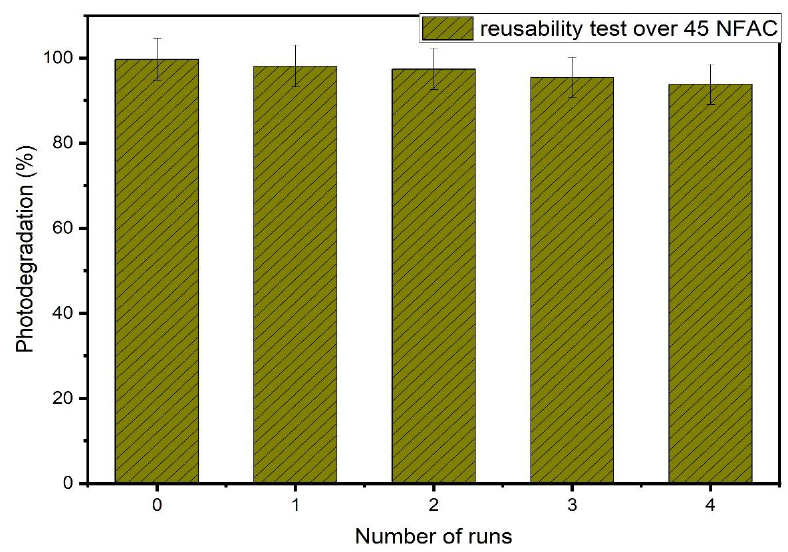
Figure 12. Effect of reusing times of photocatalyst on photocatalytic degradation of RB over 45NFAC nanocomposites.